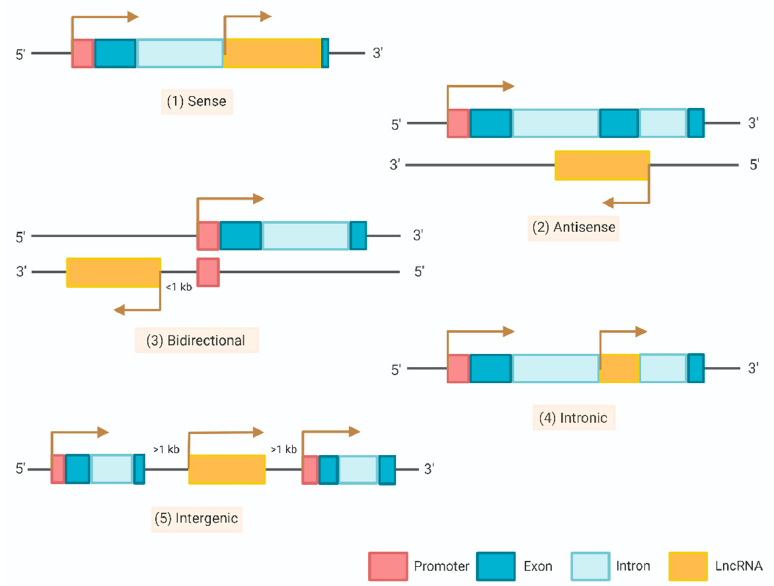
Figure 1. Depending on their genomic location relative to nearby protein-coding genes, lncRNAs could be classified as sense (lncRNAs that transcribe in the same di-rection that overlaps coding exons), antisense (lncRNAs that transcribe in the opposite direction that overlaps coding exons), bidirectional (lncRNAs with identical promoters to coding genes but transcript oppositely), intronic lncRNAs (lncRNAs that located between two introns), or intergenic lncRNAs (lncRNAs that located between two coding genes). This figure was created with Biorender.com (accessed on 6 October